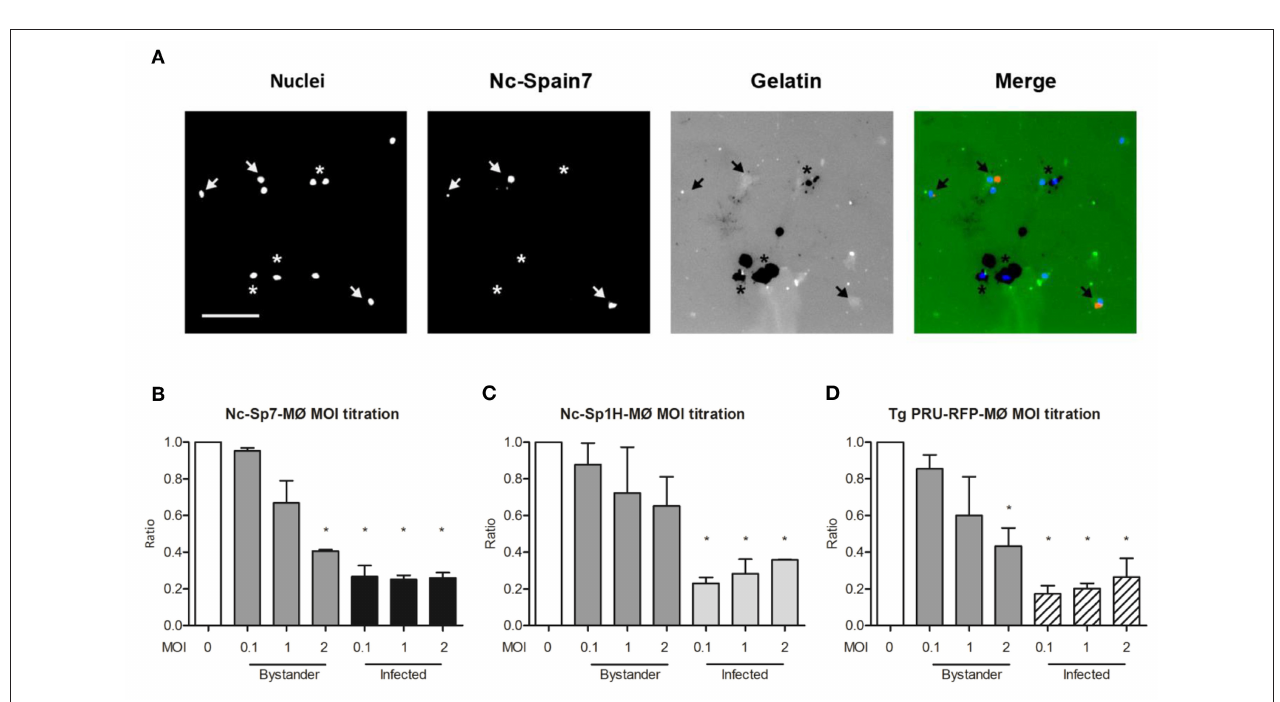
FIGURE 3 | (score 1); ( iii ) Filopodia-like extensions: present (score 0) vs. absent (score 1); iv ) Membrane veils and/or ruffles: present (score 0) vs. absent (score 1). (C) Bar graph indicates the percentage of cells that exhibited podosome loss, a rounded shape, filopodia-like extension loss and the presence of ruffles or veils, relative to